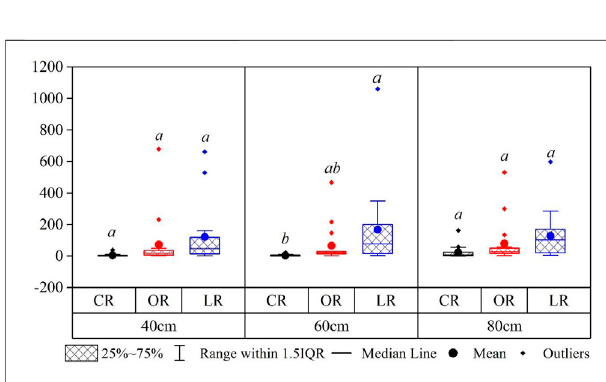
FIGURE 8 | Sediment yield under CR, LR, and OR and three ridge widths, and boxes labeled with different letters within groups indicate signi fi cant differences at p < 0.05. CR, OR, and LR represent cross-ridge tillage, oblique-ridge tillage, and longitudinal-ridge tillage, respectively. 40, 60, and 80 cm represent 40 cm ridge width, 60 cm ridge width, and 80 cm ridge width, respectively.